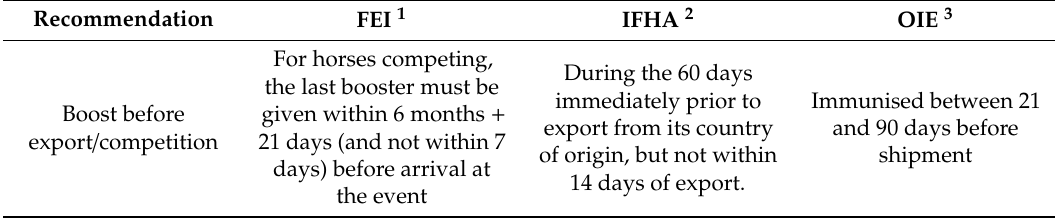
Table 1. Recommendations for equine influenza